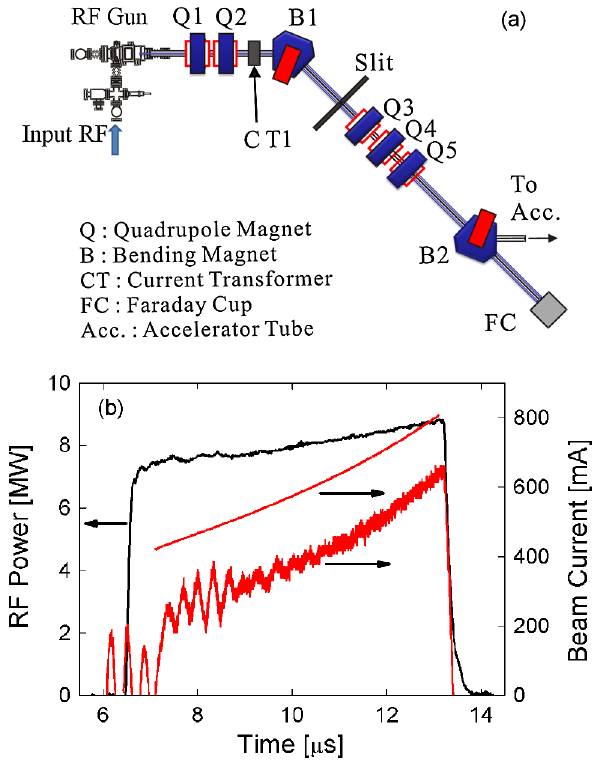
FIG. 6. Experimental setup for measuring beam current be- yond the gun aperture (a). Experimental results for input rf power and beam current with simulation results